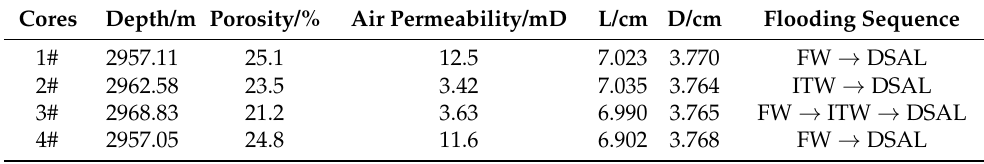
Table 3. Basic parameters of the core plugs.